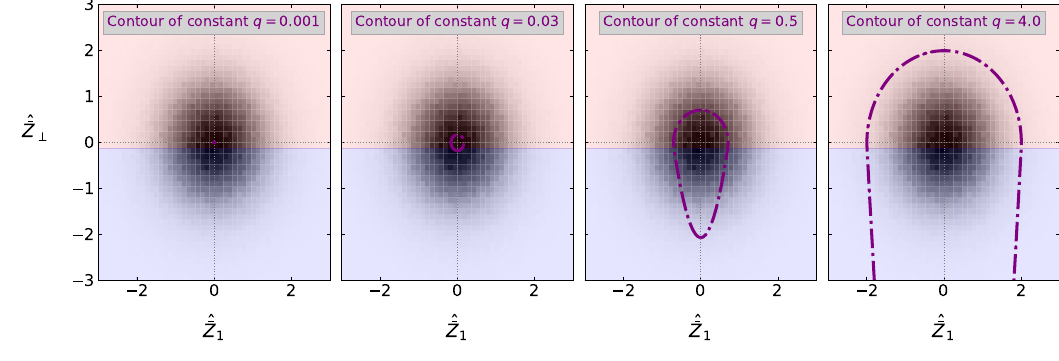
ˆ¯ Z ˆ¯ Z ) -contours which lead to four different values of q ≡ q , Figure 13: ( ⊥ 1 shows the integrands when we integrate the density along each contour.